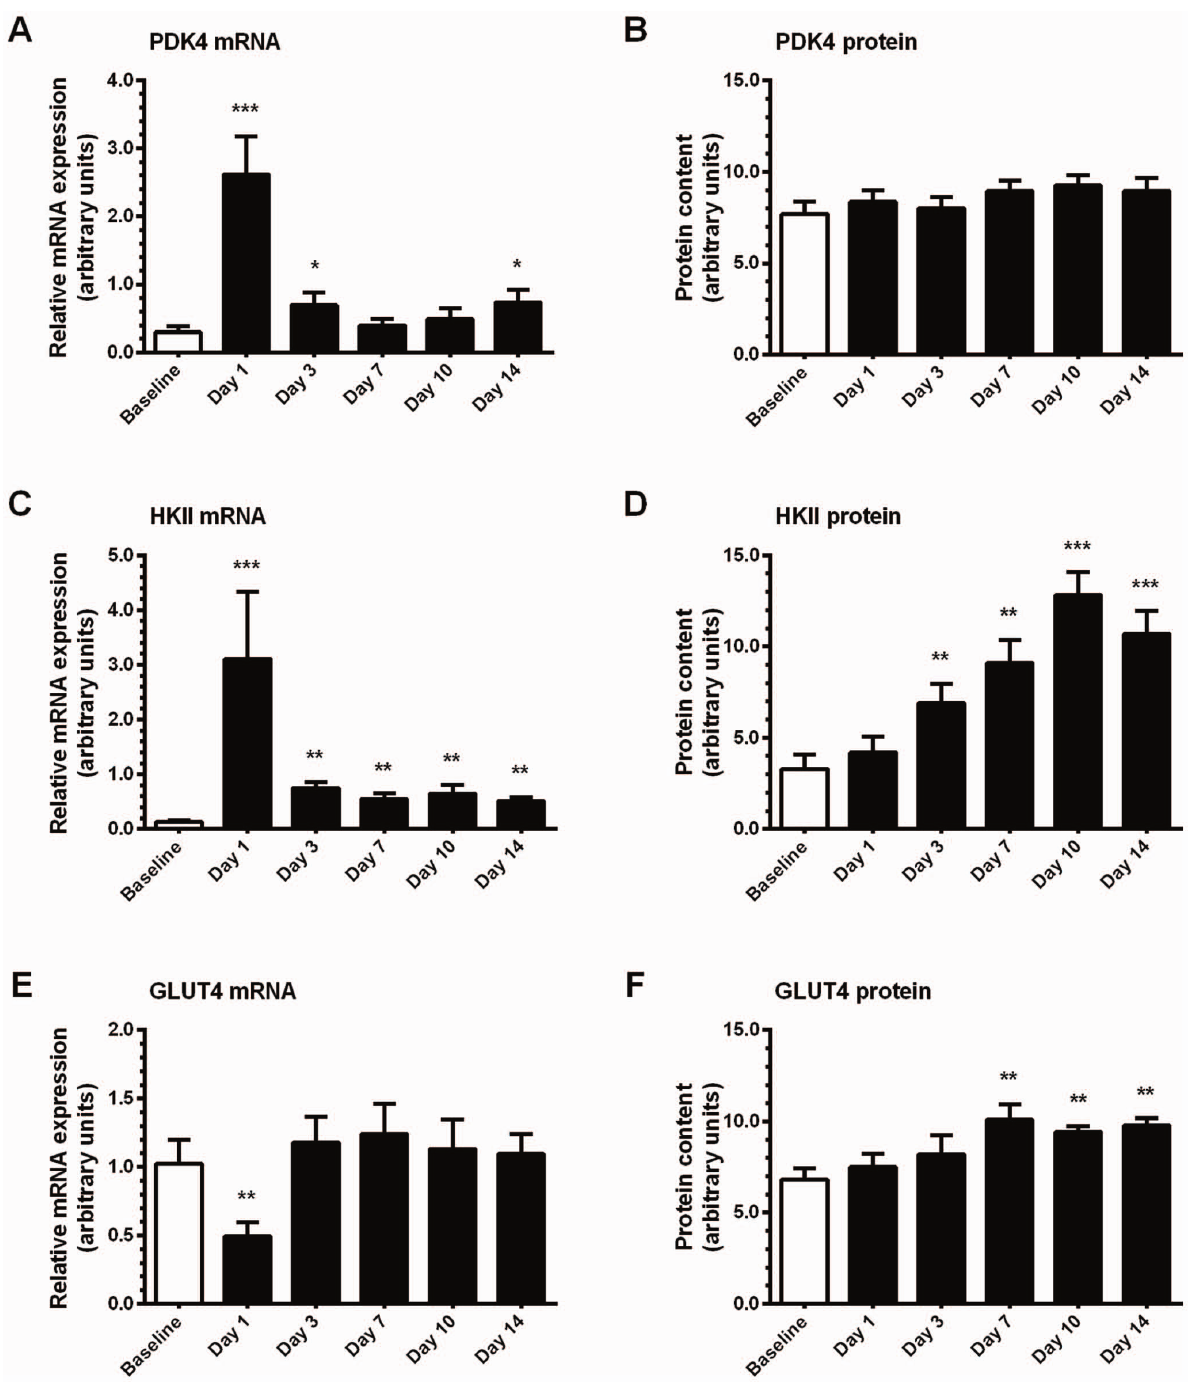
Figure 6. Training-induced alterations in gene expression of selected metabolic targets. A, relative mRNA expression of PDK4. B, protein content of PDK4. C, relative mRNA expression of HKII. D, protein content of HKII. E, relative mRNA expression of GLUT4. F, protein content of GLUT4. mRNA expression was normalized to the housekeeping gene GAPDH. Values are mean 6 SEM, n=7–8. * trend for a significant difference compared to Baseline (P , 0.1), ** significantly different from Baseline (P , 0.05), *** significantly different from Baseline (P ,